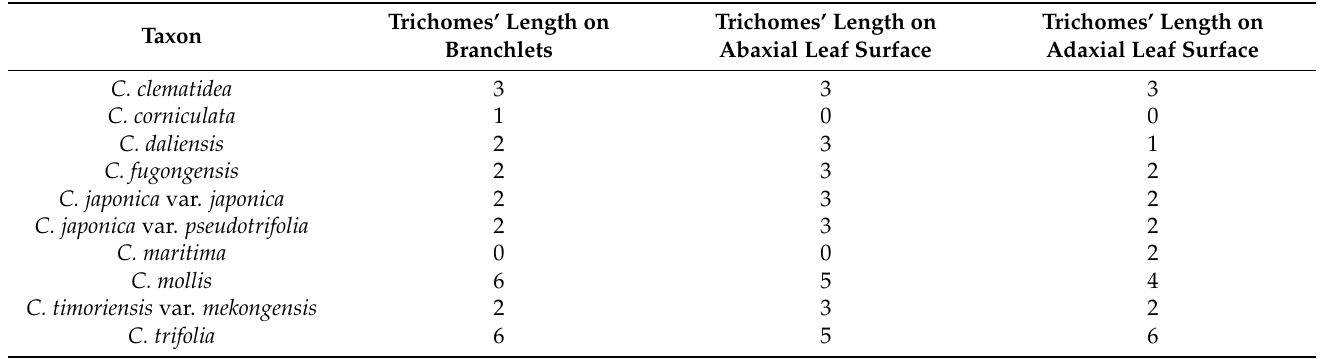
Table 4. Categorical features of trichomes on branchlets and leaves.